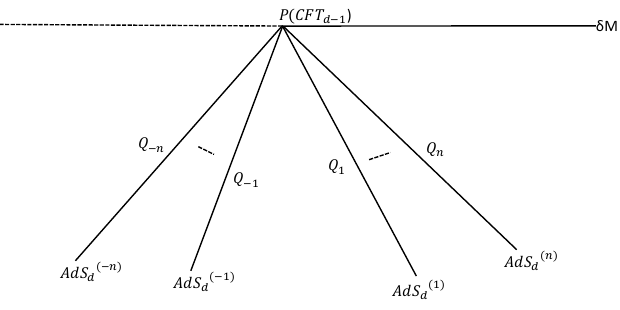
Figure 2 . 2 n Karch-Randall branes, Q − n, − n +1 ,..., 1 , 2 ,...,n − 1 ,n embedded in AdS d +1 . P is the defect. Multiverse is described by 2 n Karch-Randall branes which are d -dimensional objects and defect is ( d − 1) -dimensional